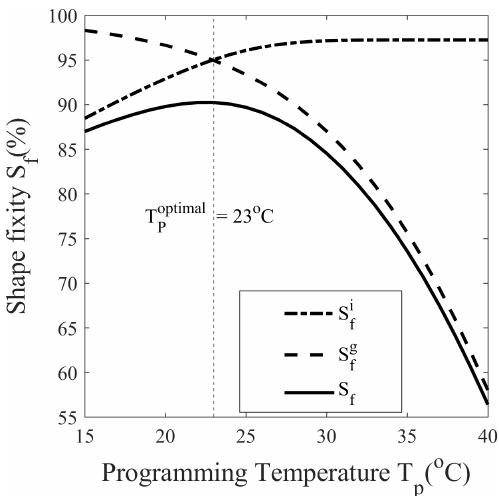
Figure 17. Variation of instantaneous, gradual, and overall shape fixity measured after the isothermal recovery step of thermomechanical cycles performed at programming temperatures ranging from 15 to 40